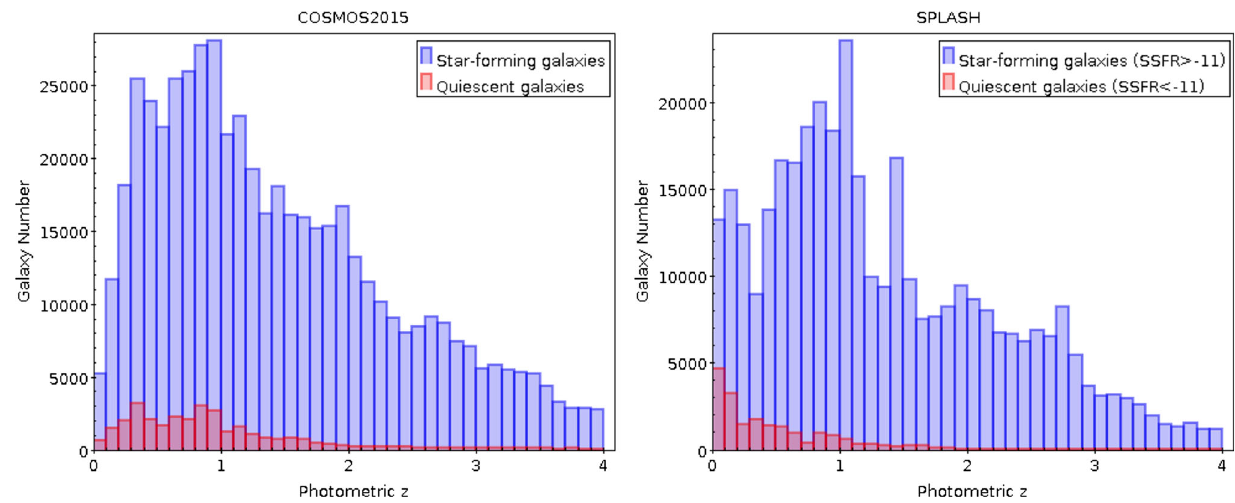
Fig. 10 Histograms showing the galaxy distribution numbers in terms of the redshift for the COSMOS2015 (left) and SPLASH (right) sub- samplesofbluestarforminggalaxiesandredquiescentones.Labelsare as in the legends. The COSMOS2015 galaxies were separated by color